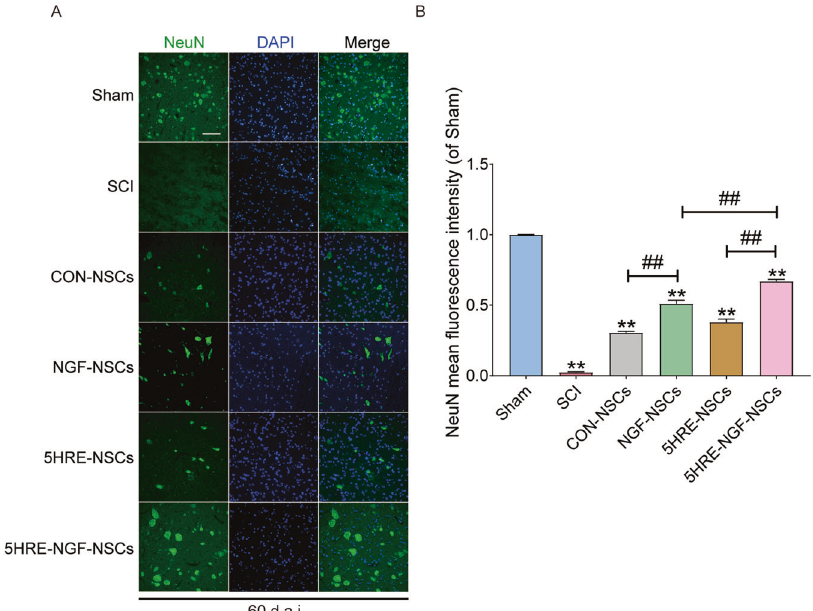
Fig. 6 Implement of NSCs and NGF, and application of hypoxia condition increased the expression of NeuN + proteins at the day of 60. A Immuno fl uorescence staining of NeuN in spinal cord lesions. The nuclei are labeled by DAPI (blue). The bright green dots are NeuN + proteins, magni fi cation was ×20. B Analysis of positive cells in immuno fl uorescence staining. ** signify P < 0.01 versus the Sham group, ## signify P < 0.01. Data are the mean values ± SD, n =